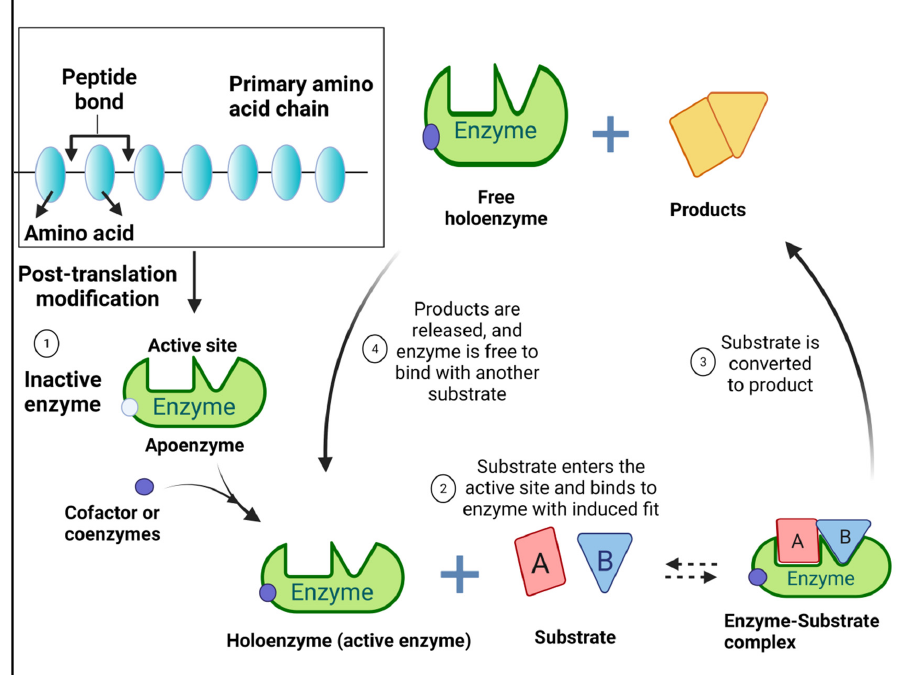
Figure 1. Schematic illustration for enzyme structure, activation, and steps of enzyme and substrate interaction.